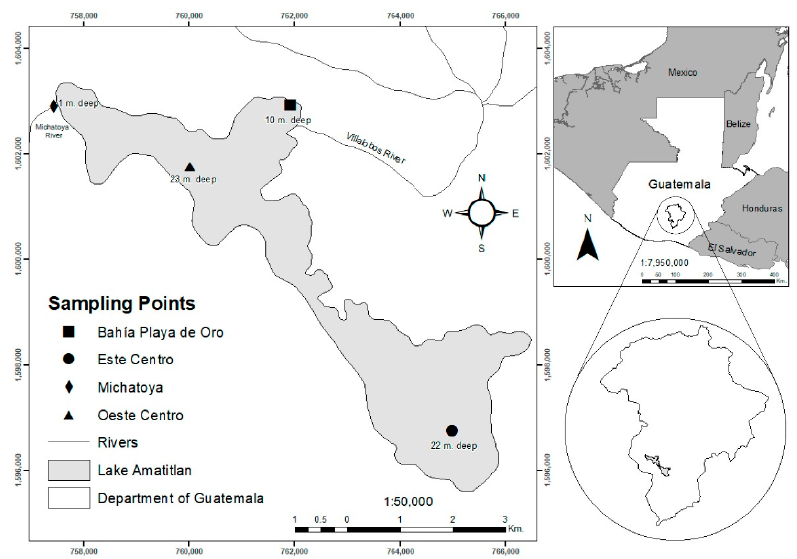
Figure 1. Location of Lake Amatitlán and sampling points for the biotic collection methodology. Water-filtered, vertical, and horizontal trawls as defined by Cervantes-Martínez & Gutiérrez-Aguirre (2015) [2].